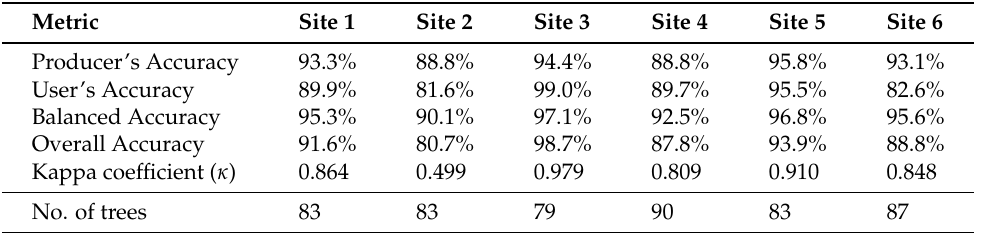
Table 7. Quality metrics of the accuracy assessment in the six validation sites taking into account the different relief and the occurrence of the tree